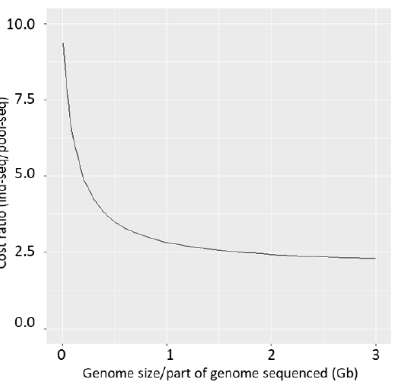
Figure 6. Cost ratio ind-seq/pool-seq. The x-axis represents the genome size or part of the genome sequenced (Gb) in case of reduced representation techniques. The y-axis is the ratio of the total cost of ind-seq/pool-seq (assuming 1400× total coverage for ind-seq and 700× total coverage for pool-seq).